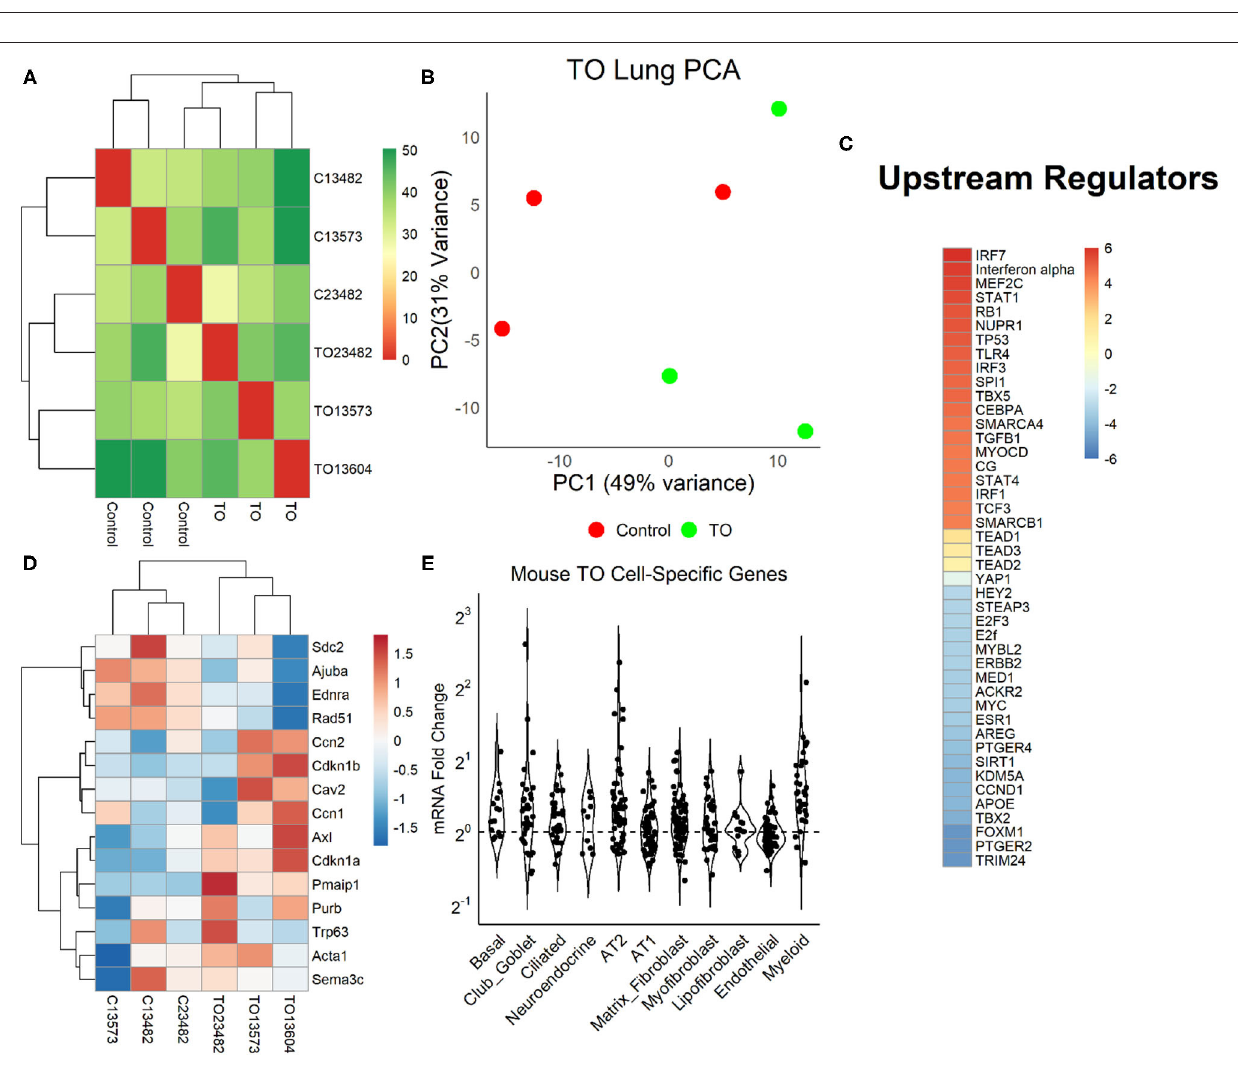
FIGURE 4 | Yap in mouse tracheal occlusion (TO) lung. (A) mRNAs from the lungs of three control and three TO fetuses analyzed by mRNA-seq. As assessed by sample distances, TO and control lungs were most similar to one another. (B) Principal component plot showing incomplete separation of control from TO specimens. (C) Ingenuity Pathway Analysis of upstream regulators of genes that were 2-fold changed between control and TO lungs showing that the regulators with the greatest predicted activation ( red ) were largely related to inflammation and those with the greatest predicted inactivation ( blue ) were mostly related to cell cycle. Yap is transcriptionally inactive when phosphorylated, and non-phosphorylated YAP recruits TEAD factors to response elements. YAP and TEAD factors were not among the top 20 activated and inactivated regulators, but were up- and downregulated consistent with the increased nuclear Yap in TO. (D) The mRNA levels of genes known to be regulated by Yap were consistent with the increased nuclear Yap in TO lung specimens. (E) Assessment of lung cell-specific mRNAs showing increased basal cell (1.17), club/goblet cell (1.15), AT2 (1.21), and myeloid cell (1.45) mRNAs in TO compared to control lungs.